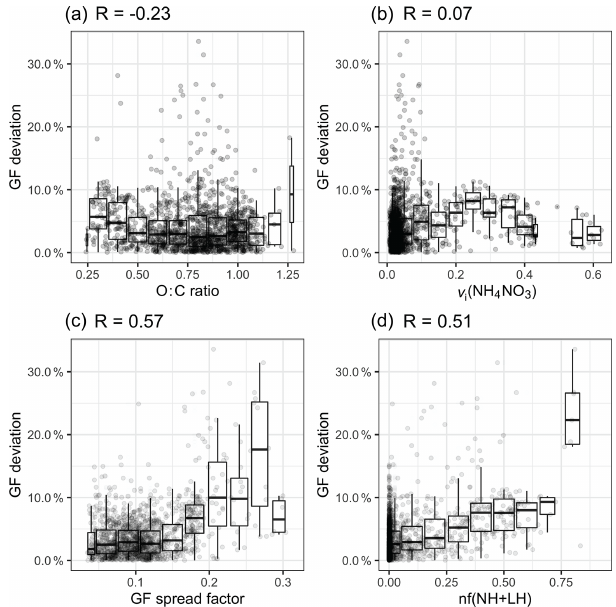
Figure 8. The relationship between the GF deviation and (a) the O : C ratio, (b) the volume fraction of NH 4 NO 3 , (c) the GF spread factor and (d) the nf(NH + LH) over the whole study